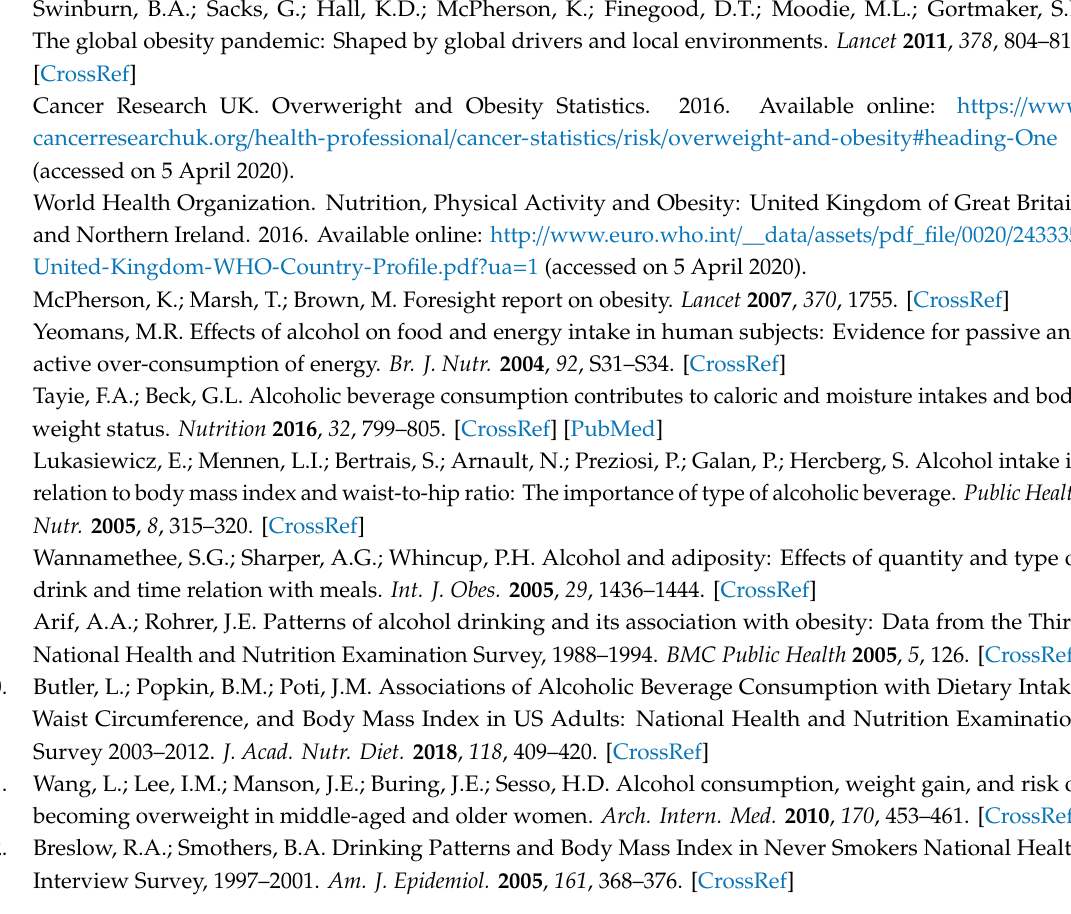
Table S1: Alcohol consumption categorization of previously published papers related to alcohol consumption and obesity, Table S2: Multivariable-adjusted associations between alcohol consumption and BMI (including underweight participants) and body fat percentage in the UK Biobank according to UK Drinking Guidelines categorization ( n = 282,572), Table S3: Multivariable-adjusted associations between BMI and body fat percentage with alcohol consumption in the UK Biobank with adjustment for education ( n = 171,772), Table S4: Multiple logistic regression describing the associations between alcohol consumption and overweight including obesity in the UK Biobank ( n = 281,588), Table S5: Multivariable-adjusted associations between BMI and body fat percentage with alcohol consumption in the UK Biobank with combined never / previous drinkers ( n = 280,183), Table S6: Multivariable-adjusted associations between types of alcoholic beverages consumed and BMI (including underweight participants) and body fat percentage in the UK Biobank ( n = 282,572), Table S7: Multiple logistic regression describing the associations between overweight and obesity with types of alcoholic beverages in the UK Biobank ( n =